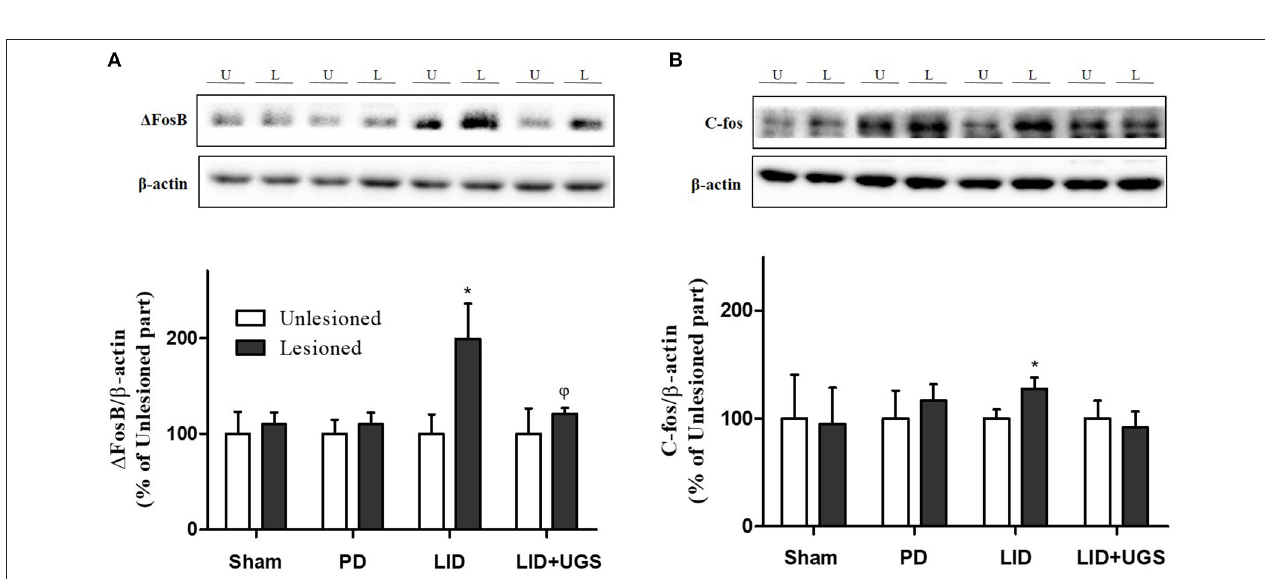
FIGURE 9 | UGS inhibited the expression of 1 FosB and c-fos after development of LID. Representative band images and the quantification data of expression of 1 FosB (A) and c-fos (B) for western blot analysis. Values of quantification data are given as the mean ± S.E.M. ( N = 6). The significance of differences was analyzed by one-way ANOVA followed by Bonferroni’s Multiple Comparison Test: * p < 0.05; mean values were significantly different from the unlesioned part of each group. φ p < 0.05; mean values were significantly different from the LID